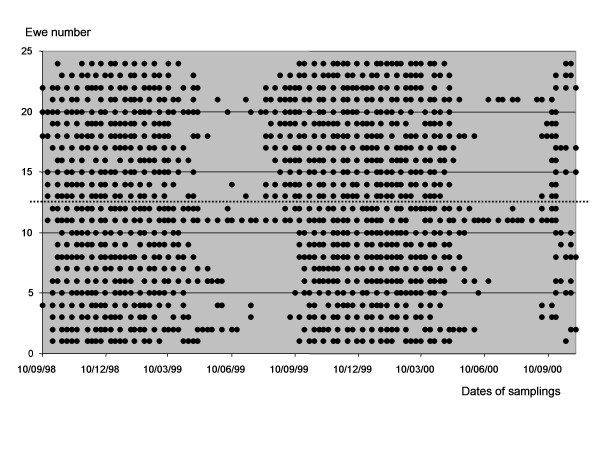
Individual ovulatory activity in Black-Belly ewes maintained under two different photoperiodic conditions. Two groups of Black-Belly ewes were maintained in light-proof rooms and subjected to either simulated temperate photoperiodic conditions (TE ewes 1-12 at the bottom of the figure, 8 to 16 hours of light per day from winter to summer solstice) or simulated tropical photoperiodic conditions (TR ewes 13-24 upper part of the figure, 11 to 13 hours of light per day from winter to summer solstice) for 25 months. Ovulatory activity was assessed by once-weekly determinations of plasma progesterone by radioimmunoassay. One line represents one ewe. A single dot represents one progesterone measurement above 0.75 ng/ml of plasma and is considered as indicative of the presence of at least one corpus luteum. All ewes were present until the end of the experiment.